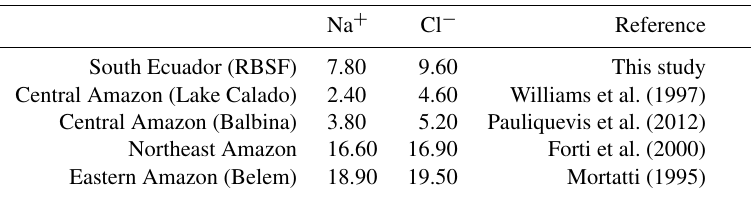
Table 4. Comparison of the mean concentration of Na + and Cl − in precipitation in this study with data from other sites in the Amazon basin. The values represent volume-weighted means expressed in µeq.L − 1